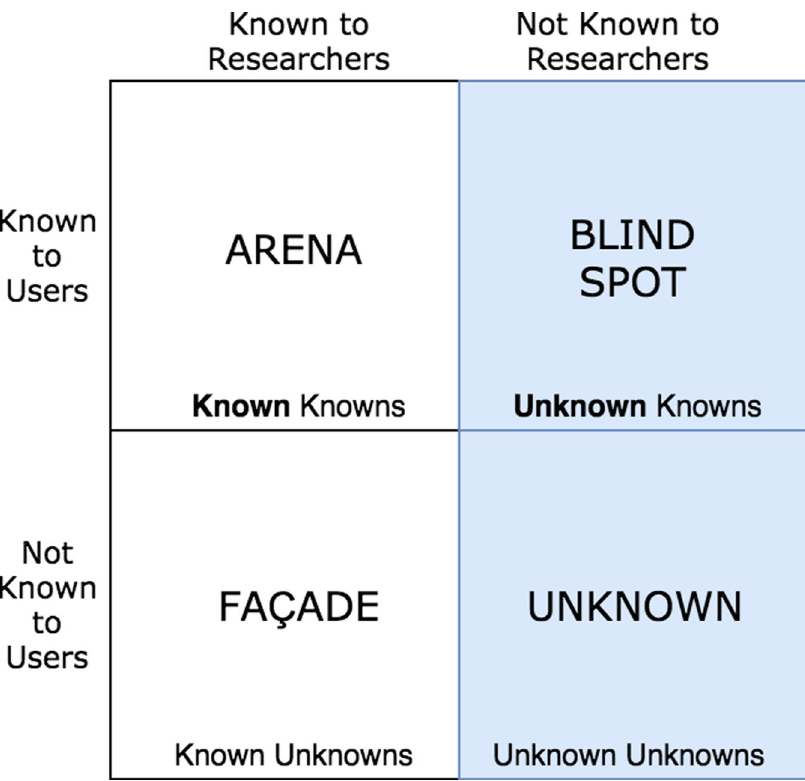
Fig. 1 A Johari window adapted from Shenton (2007). It maps users ’ knowledge to researchers ’ knowledge of issues.